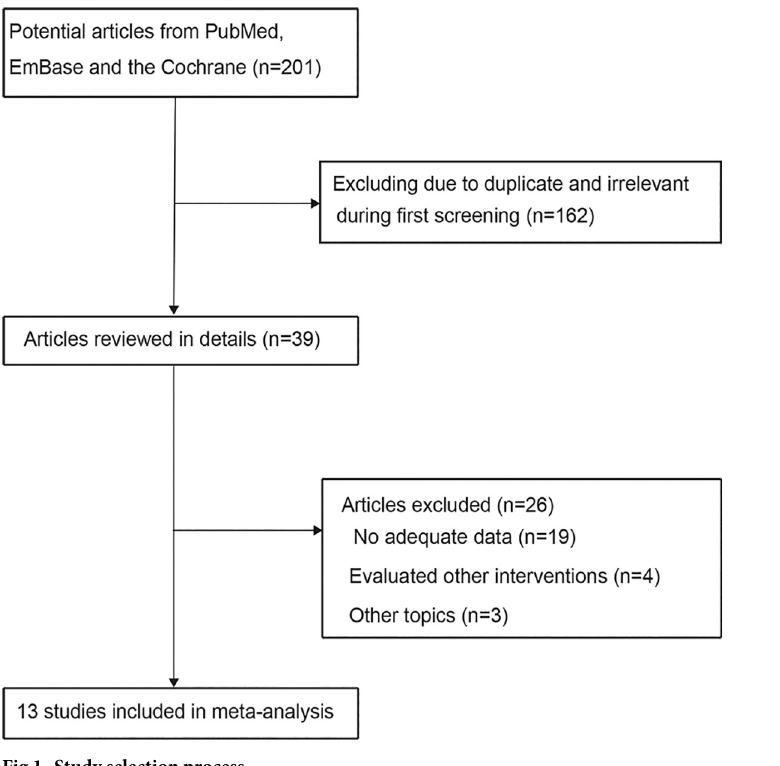
Fig 1. Study selection